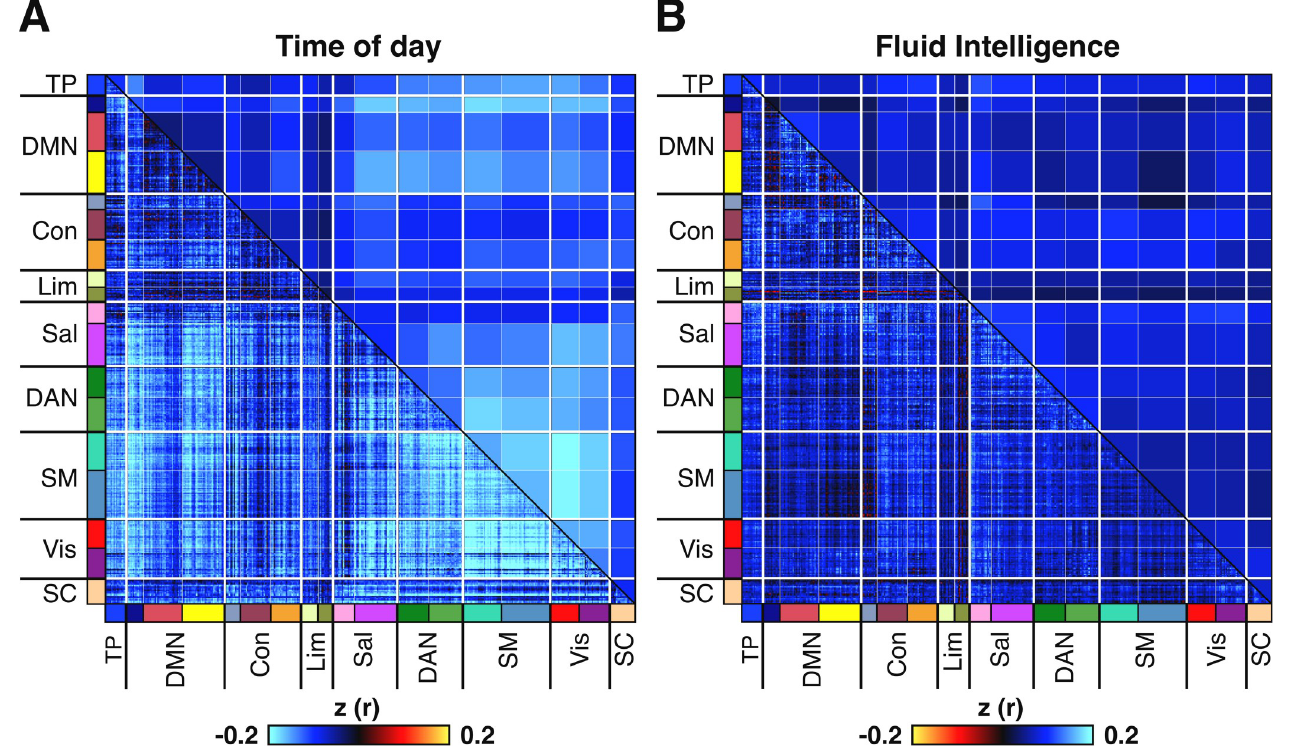
Fig 6. RSFC is negatively correlated with time of day across participants, with a magnitude surpassing the strength of correlation between fluid intelligence and RSFC. Results shown are for session 1 (see S5 Fig for session 2). (A) Correlation between time of day and RSFC across participants. (B) Correlation between fluid intelligence and RSFC across participants (with inverted colour scale to facilitate visual comparison with time of day effects). Colours in lower triangular of correlation matrix denote Pearson correlation coefficients. Colours in the upper triangular denote r values from the lower triangular averaged within network pairs. Colours on label axes denote correspondence of 419 regions to 17 large-scale cortical networks and to SC. Association between time of day and RSFC was significant in both sessions as assessed by network-based statistics (FDR-corrected at q < 0.05), whereas association between fluid intelligence and RSFC association was only significant in session 1 (FDR-corrected at q < 0.05). See Materials and methods for details of network-based statistics [51]. Fluid intelligence was chosen because it is a widely studied measure amongst resting-fMRI studies of brain-behavioural associations [50] and is one of the behavioural measures that is best predicted by resting fMRI [37,38,52]. Con, control network; DAN, dorsal attention network; DMN, default mode network; FDR, false discovery rate; fMRI, functional MRI; Lim, limbic network; RSFC, resting-state functional connectivity; Sal, salience network; SC, subcortical network; SM, somatomotor network; TP, temporal parietal network; Vis, visual